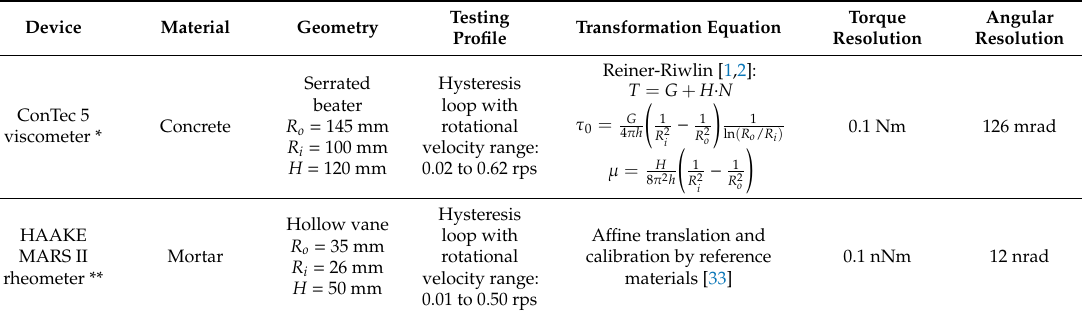
Table 2. Detailed information on the employed